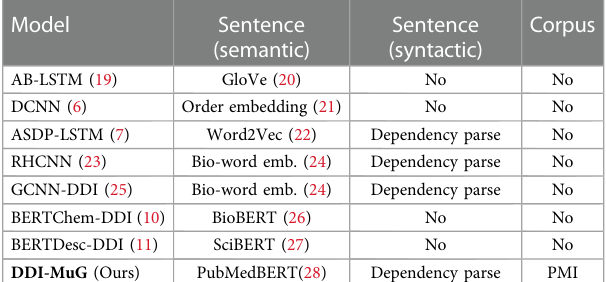
TABLE 1 Summary of previous neural network-based models and our proposed model.